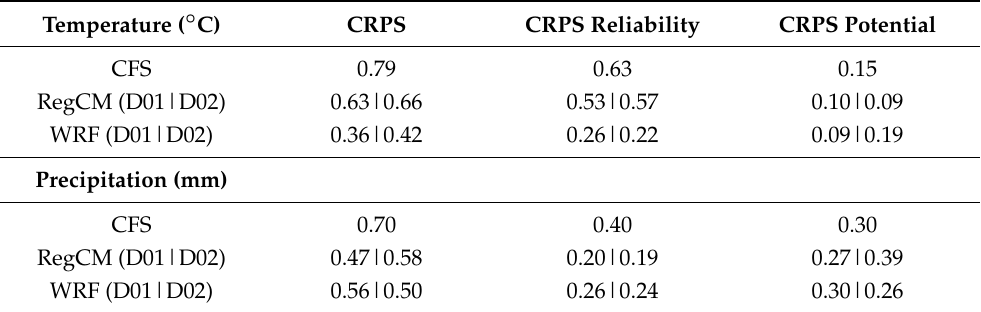
Table 3. Mean CRPS and related decomposition terms (reliability and potential) for CFS, RegCM and WRF